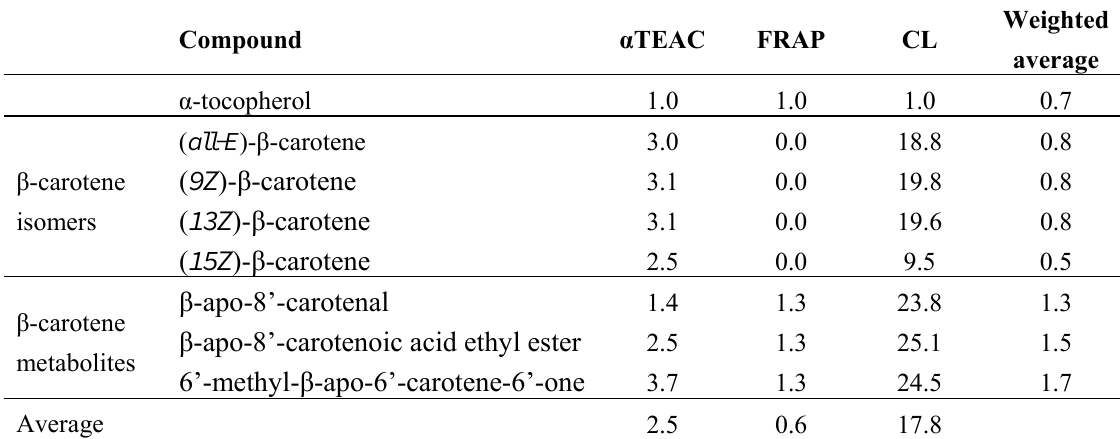
Weighted average 0.5